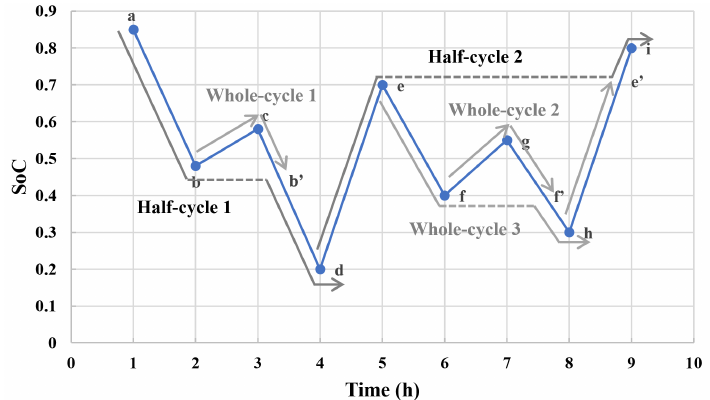
Figure 7. Example application of the rainflow counting algorithm based on a SoC